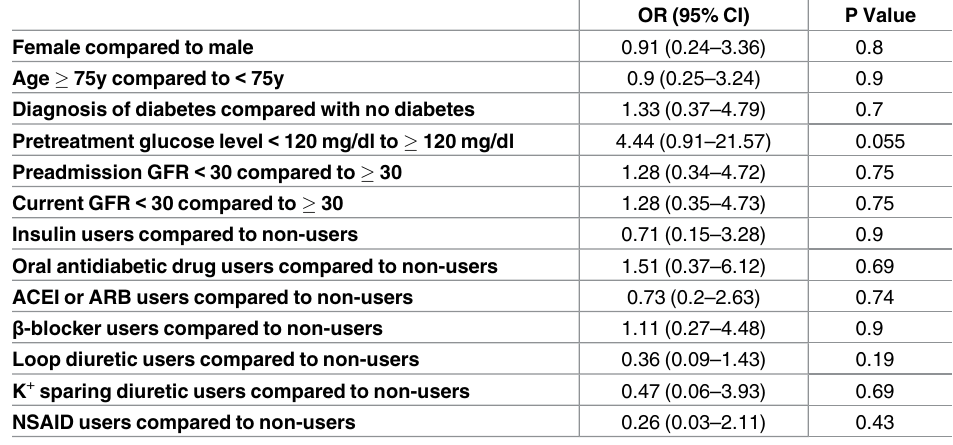
OR (95% CI) P Value